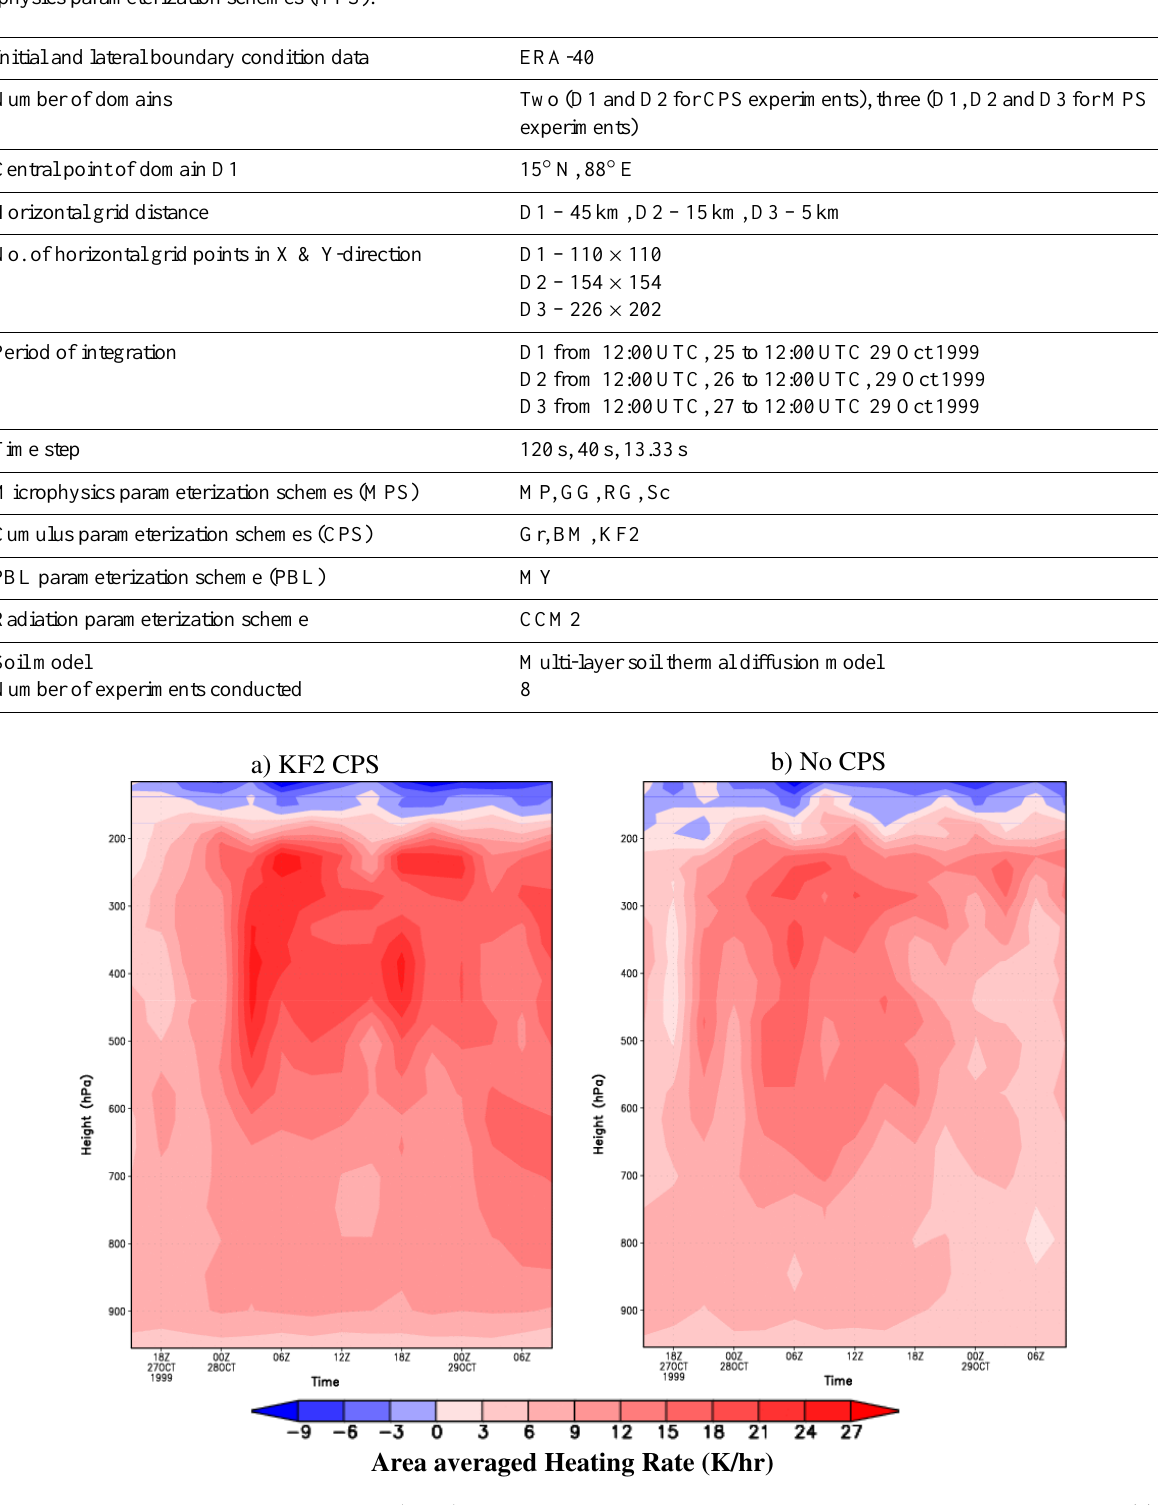
Fig. 8. Time-height cross section of heating rate (d θ /d t ) in K/h, averaged over the square area of 1 ◦ × 1 ◦ , in the storm core with (a) KF2 CPS and (b) no CPS in